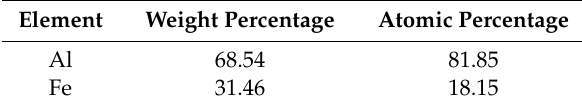
Table 6. Composition of intermetallic compounds